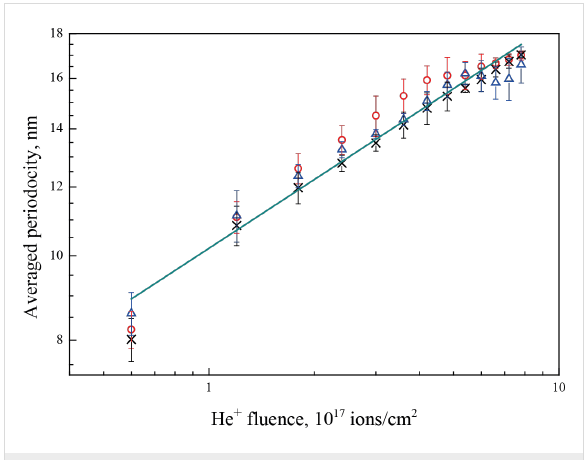
Figure 4: Dependence of the Au{111} average pattern periodicity on helium fluence for 15 keV (red circles), 25 keV (black crosses) and 35 keV (blue triangles) He +